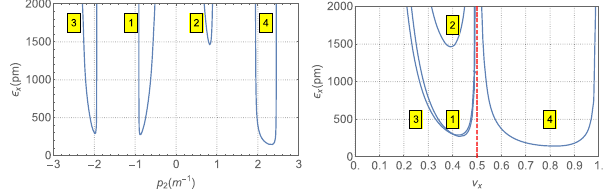
FIG. 3. Stability area of the cell in the form of tune ν x (left) and integrated strength p 1 of the first quadrupole (right) on integrated strengths p 2 of the second quadrupole.